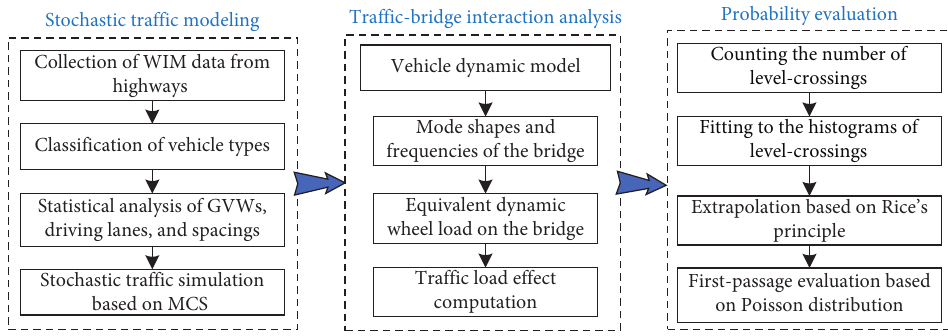
Figure 3: Flow chart of the proposed computational